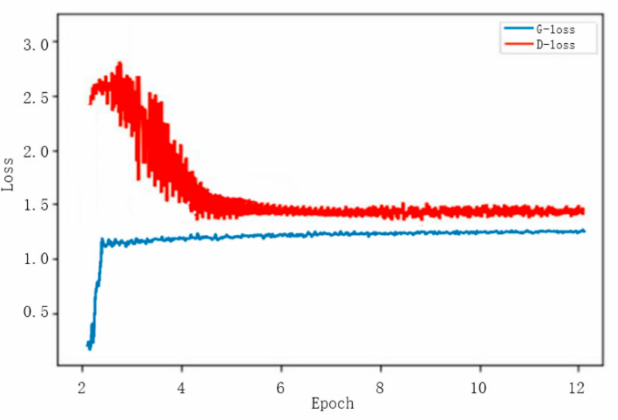
Figure 4. The topographic maps of the real and the generated EEG samples